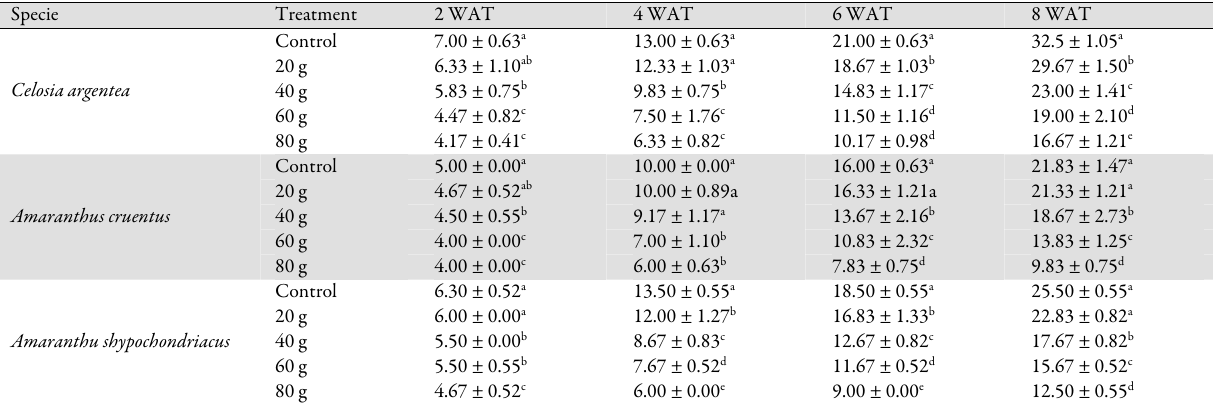
Table 2. Mean leaf number of the studied leafy vegetables to the allelopathic effect of Vitellaria parodoxa leafs Specie Treatment 2